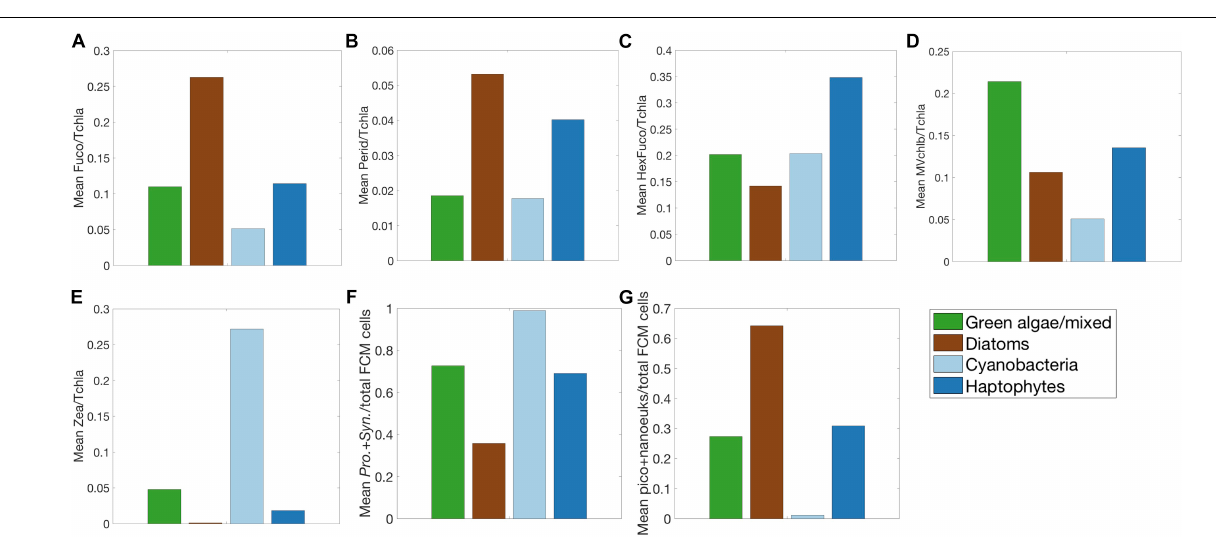
FIGURE 6 | Mean pigment ratios to total chlorophyll- a for five biomarker pigments: (A) fucoxanthin, (B) peridinin, (C) 19’hexanoyloxyfucoxanthin, (D) mono-vinyl chlorophyll b, (E) zeaxanthin and (F) Prochlorococcus + Synechococcus , and (G) pico- and nanoeukaryote fractions of total cells measured by FCM for each community detected in the community detection analysis (light blue = cyanobacteria, dark blue = haptophytes, green = green algae/mixed, brown = diatoms and